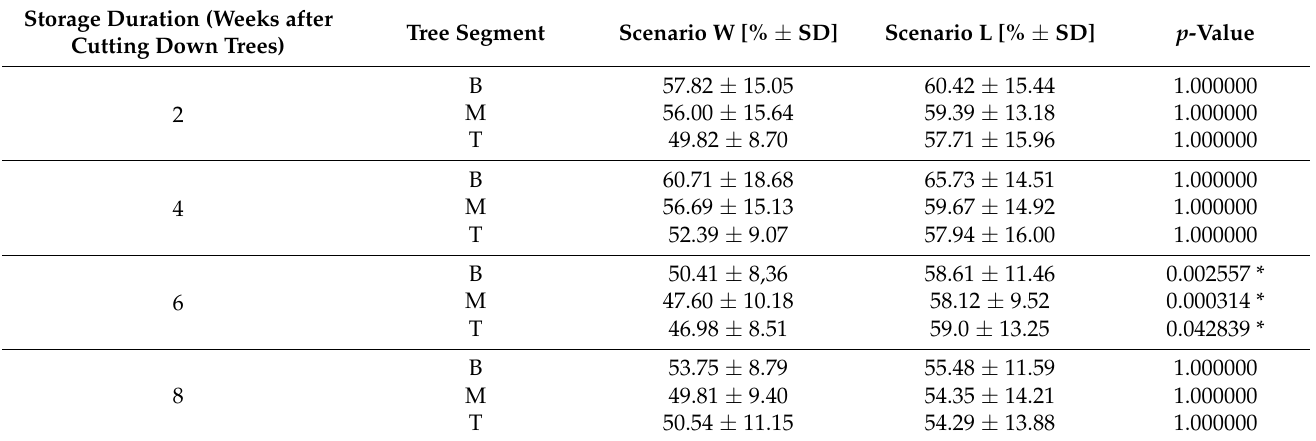
Table 5. Mean and standard deviation of MC according to storage duration, storage methods, and tree segments. The average of sapwood and heartwood data.